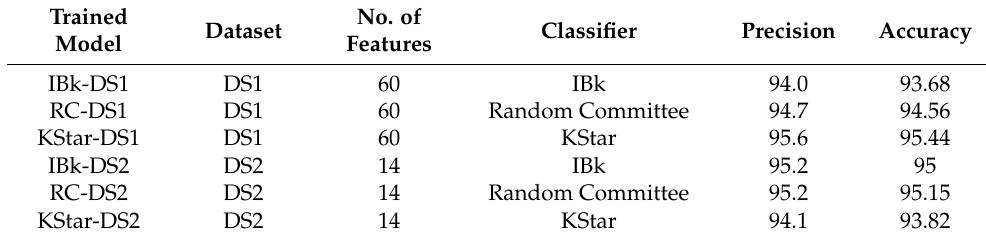
Table 11. Evaluation of the Machine Learning Models.